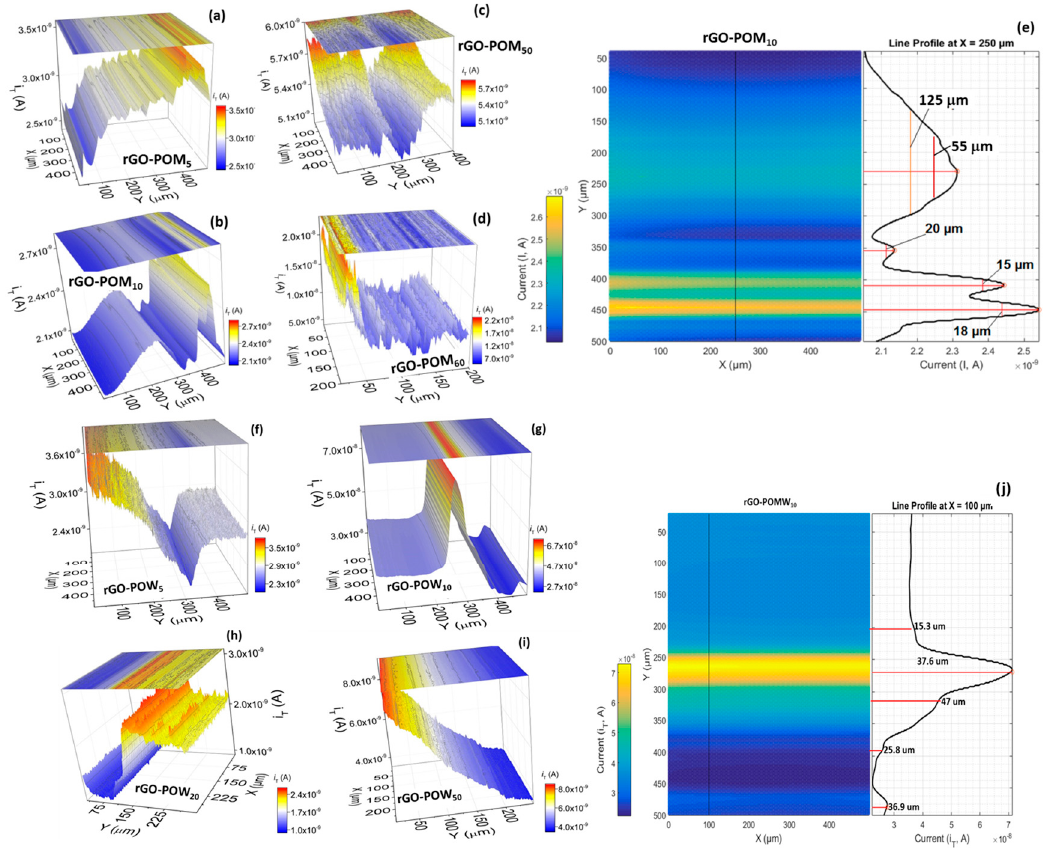
Figure 7. (Color online). Representative scanning electrochemical microscopy images in 400 μ m × 400 μ m area for: ( a – d ) rGO–POM x , x = 5, 10, 50 and 60 wt %; and ( f – i ) rGO–POW x , x = 5, 10, 20 and 50 wt % samples, displaying tip current distribution in two- and three-dimensional contour heat maps with occasional higher (peak)/lower (valley or almost flat) current behavior. Line profiles for: ( e ) rGO–POM 10 ; and ( j ) rGO–POW 5 samples displaying tip current distribution. A color bar is shown for quantitative values of the tip current.